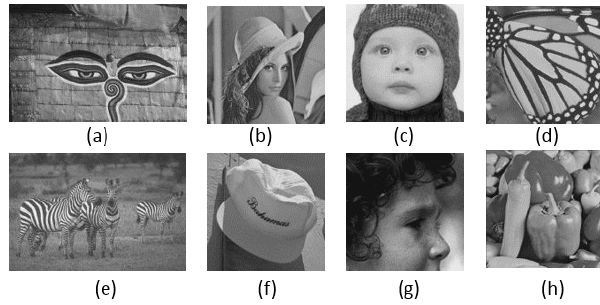
Fig. 6 Test images. Top: Artwall, Lena, Baby, Butterfly. Bottom: Zebra, Hat, Head,